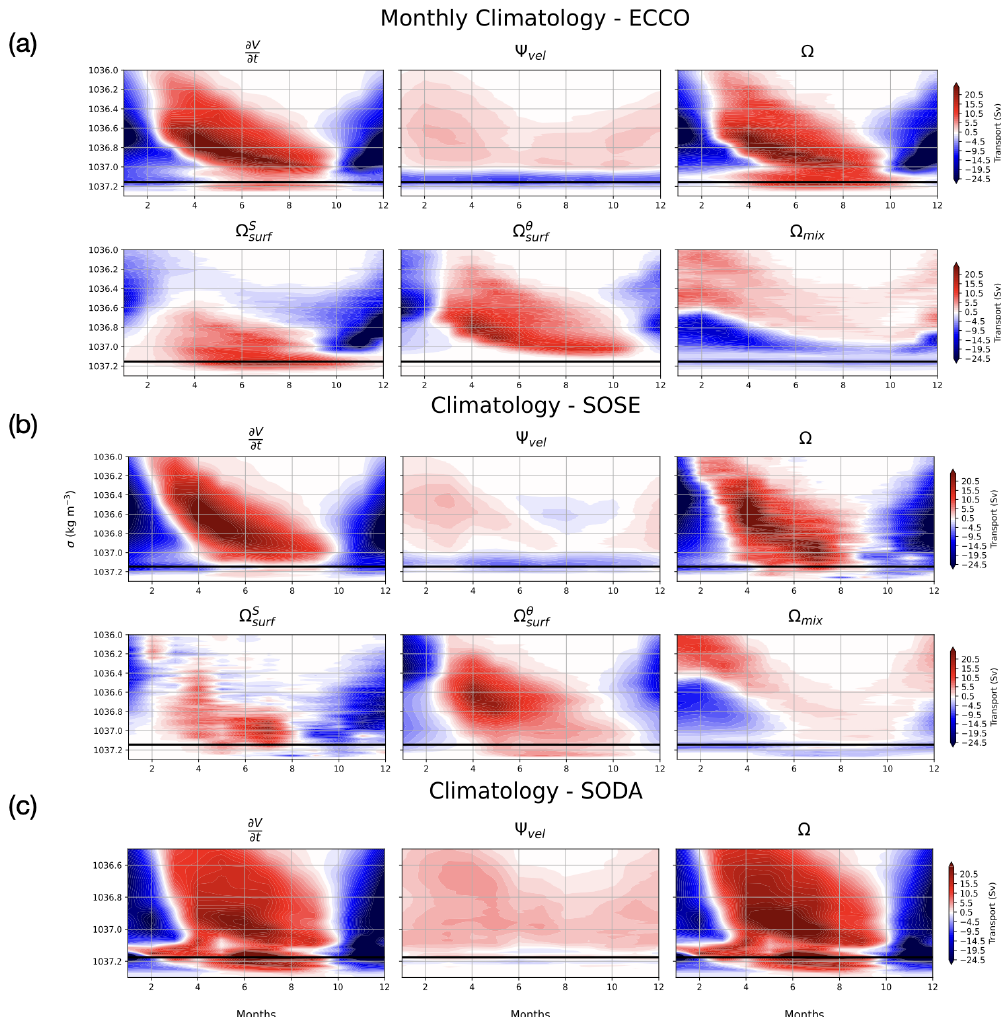
Figure 8. Monthly climatology of main WMT budget terms in top panels in ECCO (a) , SOSE (b) and SODA (c) and sources of transformation (bottom panels) in ECCO (a) and SOSE (b) . The horizontal black line represents the bottom water boundary in each model (1037.155kgm − 3 for ECCO, 1037.145kgm − 3 for SOSE and 1037.175kgm − 3 for